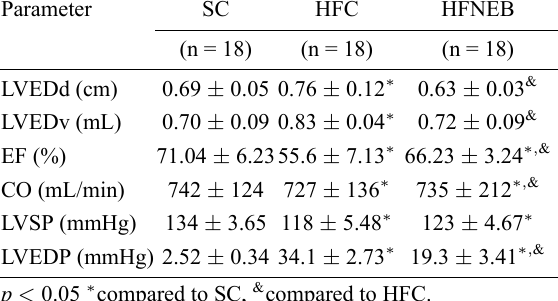
Table 2. Cardiac function and ventricular